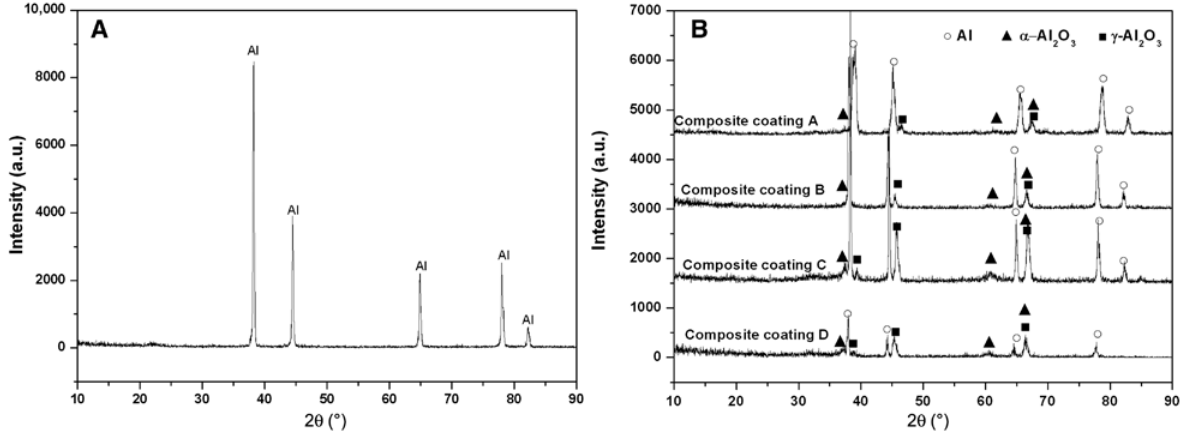
O -Al composite 2 3